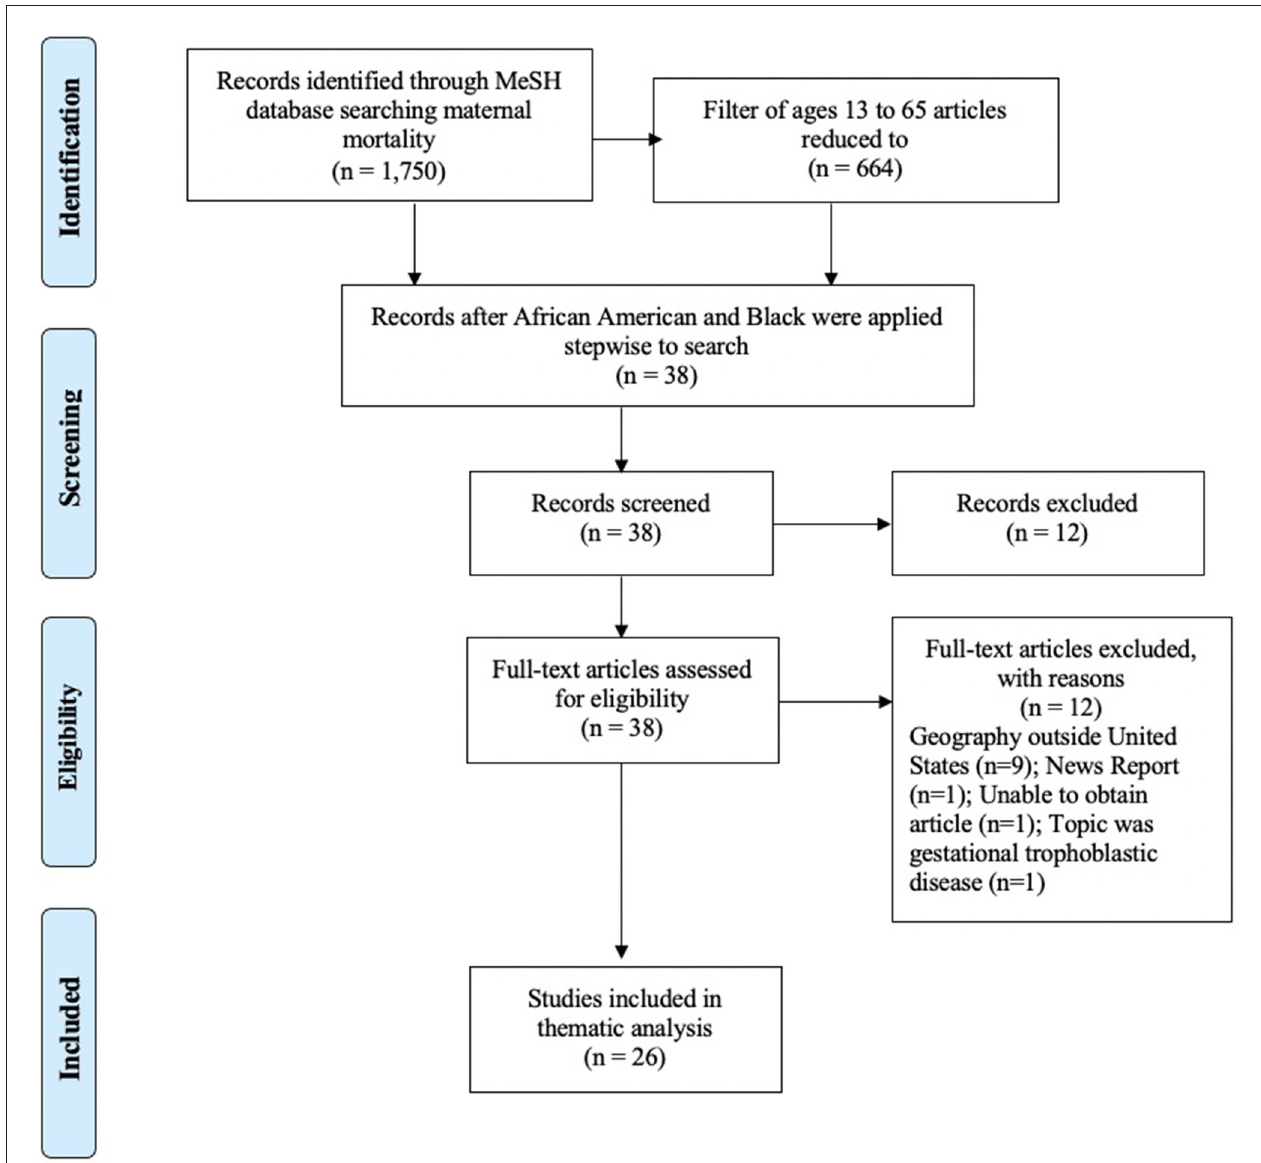
FIGURE 2 | PRISMA for Scoping Review Phase I—Clarify